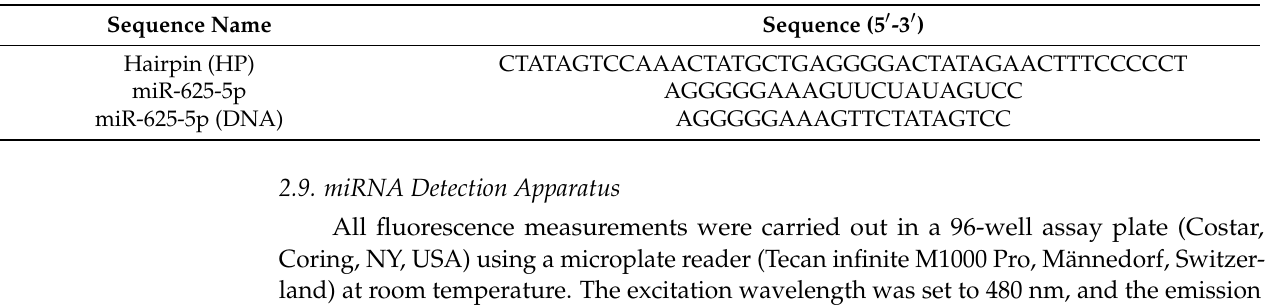
Table 1. The required sequences of our detection